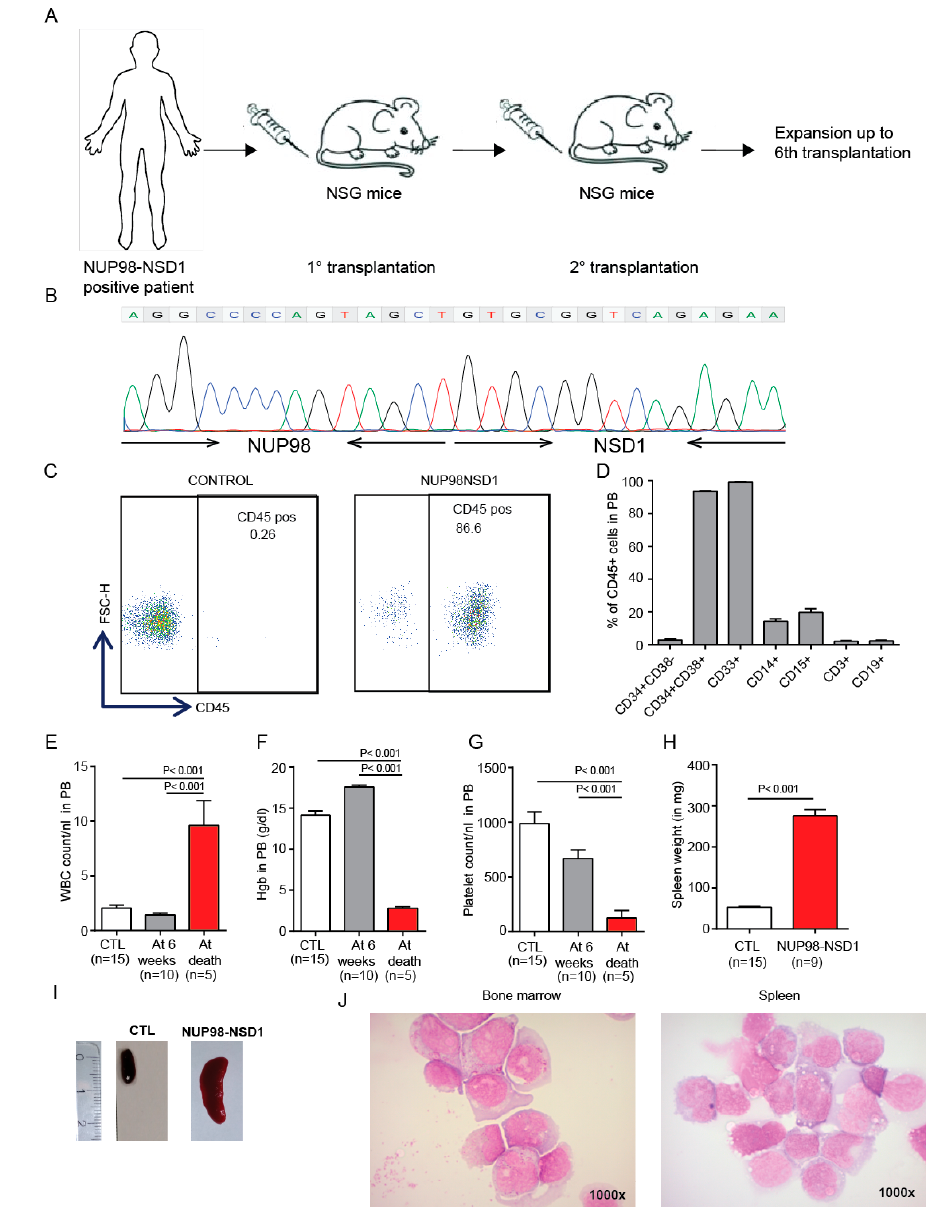
Figure 4. Establishment and characterization of a NUP98-NSD1 patient-derived xenograft (PDX) model. ( A ) Development of a patient-derived xenograft (PDX) model from a NUP98-NSD1 fusion-positive patient. ( B ) Identification of the NUP98-NSD1 fusion through Sanger sequencing, where the 5 ′ end (exon 11) of NUP98 is fused to the 3 ′ end (exon6) of NSD1. ( C ) Engraftment of human CD45-positive NUP98-NSD1 AML cells in peripheral blood 10 weeks after transplantation. ( D ) Immunophenotype of human CD45-positive NUP98-NSD1 AML cells in the peripheral blood of PDX mice. ( E ) WBC count in peripheral blood of PDX-AML mice at 6 weeks after transplantation (before the development of AML) and at sacrifice (6th transplantation) (mean ± SEM). ( F ) Hemoglobin of PDX-AML mice at 6 weeks after transplantation (before the development of AML) and at sacrifice (6th transplantation) (mean ± SEM). ( G ) Platelet count in peripheral blood of PDX-AML mice at 6 weeks after transplantation (before the development of AML) and at sacrifice (6th transplantation) (mean ± SEM). ( H ) Spleen weight at death of the PDX model (6th transplantation) (mean ± SEM). ( I ) Representative image of a spleen at sacrifice / death. ( J ) Representative Wright–Giemsa-stained cytospin preparations of bone marrow, spleen, and blood cells from moribund mice (1000 × ) (6th